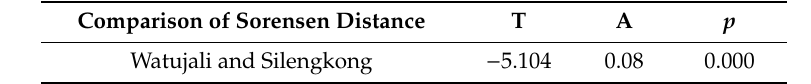
Table 3. Summary statistic of comparison analysis using multi-response permutation procedure (MRPP) analysis.